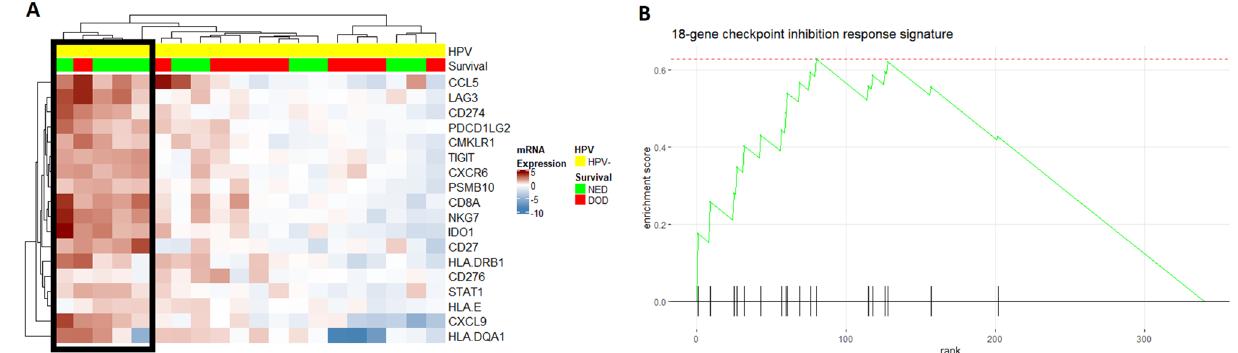
Figure 3. ( A ) Heatmap of all HPV-negative samples for the 18 genes in the tumor inflammation signature. The black box marks samples from cluster 1 in ( B ) Gene set enrichment plot for the 18-gene signature in relation to survival. Genes in the signature are marked on the x-axis and ranked from left to right based on their log2-fold change between tumors responding to treatment ant non-responding. Analyses of mRNA expression were performed in R 3.6.2. Heatmaps were plotted with the R package ComplexHeatmap 40 . (https ://www.bioco nduct or.org/packa ges/relea se/bioc/html/Compl exHea tmap.html).